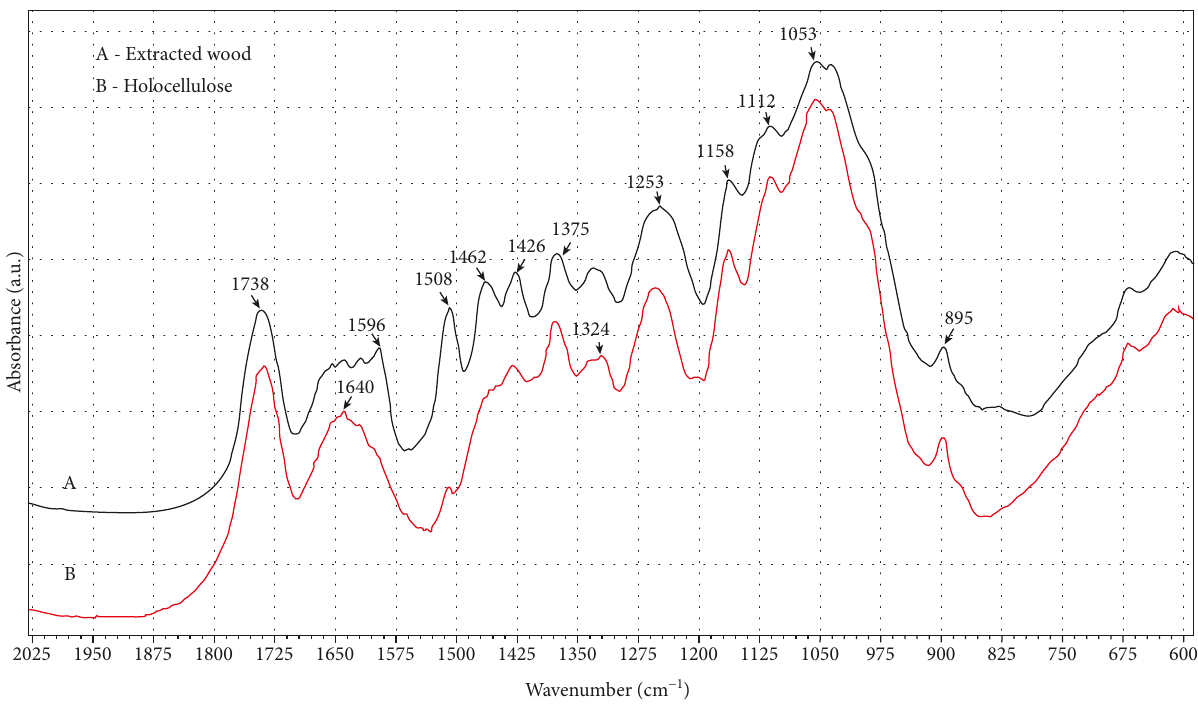
Figure 3: FT-IR spectra of extracted wood fl our and holocellulose prepared from black